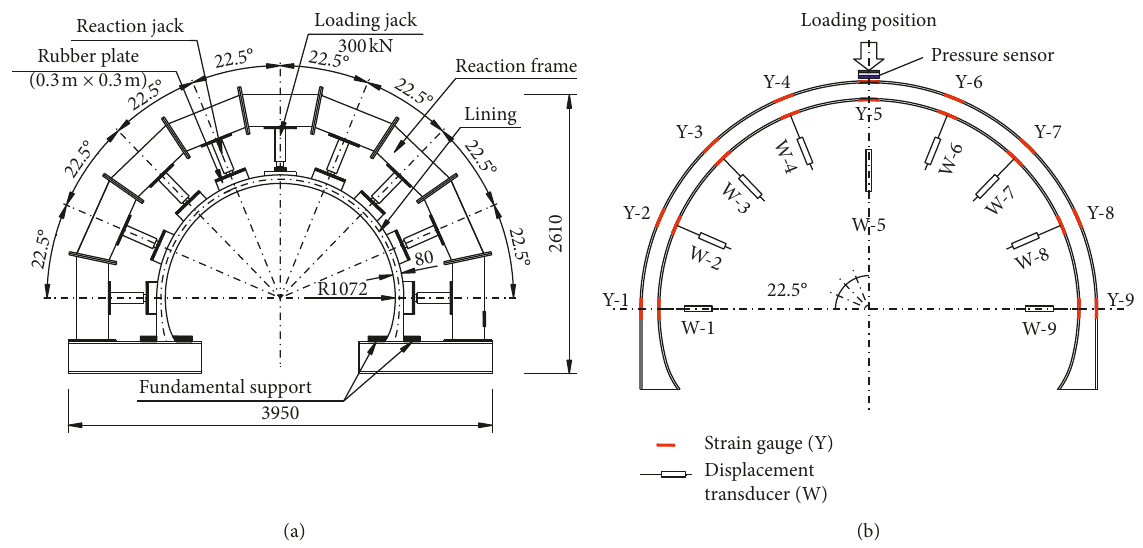
Figure 1: Diagram of layout of loading device and sensor (unit: mm), (a) model device, (b) layout of testing sensor.